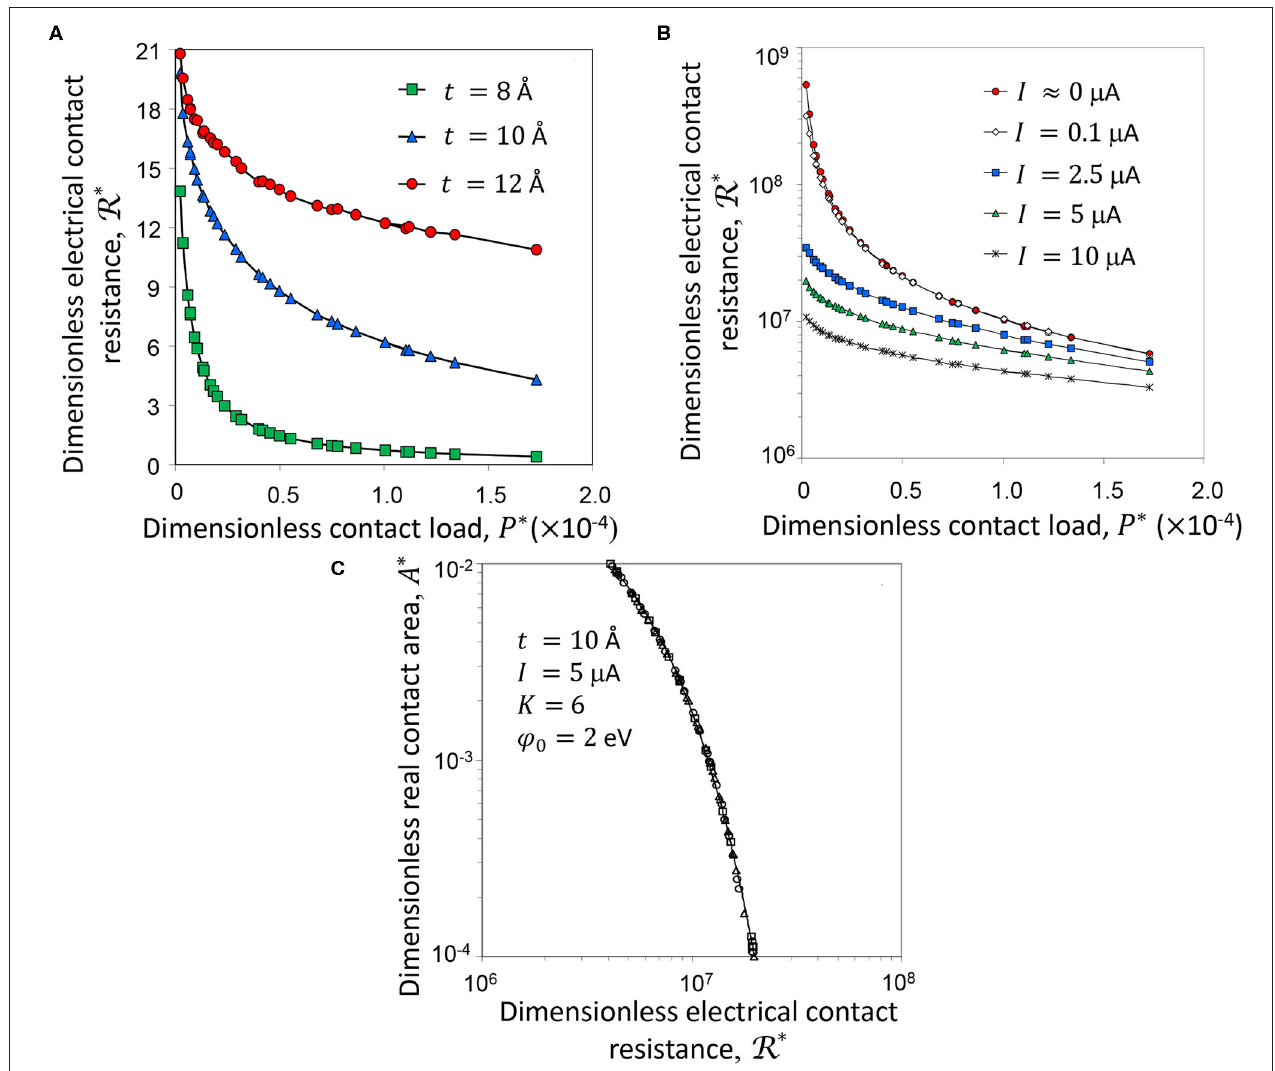
FIGURE 11 | (A) Dimensionless electrical contact resistance R * vs. dimensionless contact load P * for t ϕ 0 2eV, and I 5 µ A), (B) dimensionless electrical contact resistance R * vs. dimensionless contact load P * for I = = 10 Å, K 6, ϕ 0 2eV), and (C) dimensionless contact area A * vs. dimensionless electrical contact resistance R * (2 < D < 2.5, 10 − 11 = = 288, and 391,